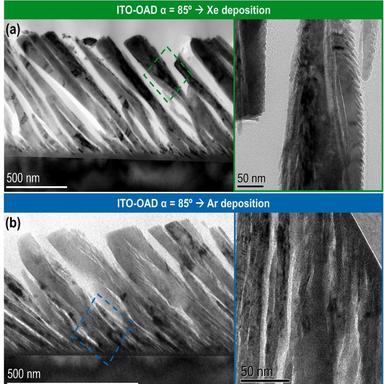
Bright-field TEM overviews of ITO-OAD films prepared by (a) Xe and (b) Ar IBS at α = 85◦. The insets place emphasis on the remarkable difference between the shape of the NCs generated as a function of the sputtered ion.